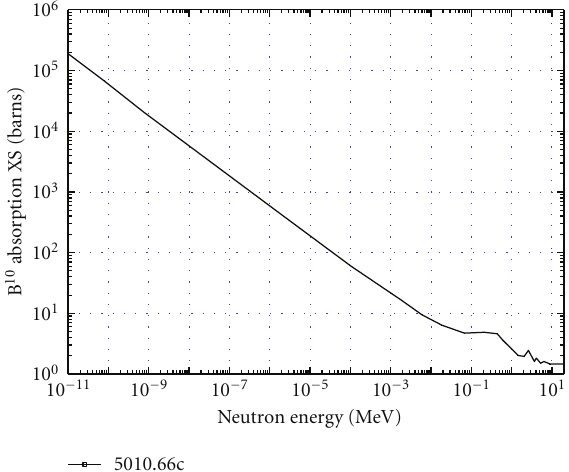
Figure 11: B 10 total neutron disappearance cross-section (MT 101) from ENDF/B-VI library used by